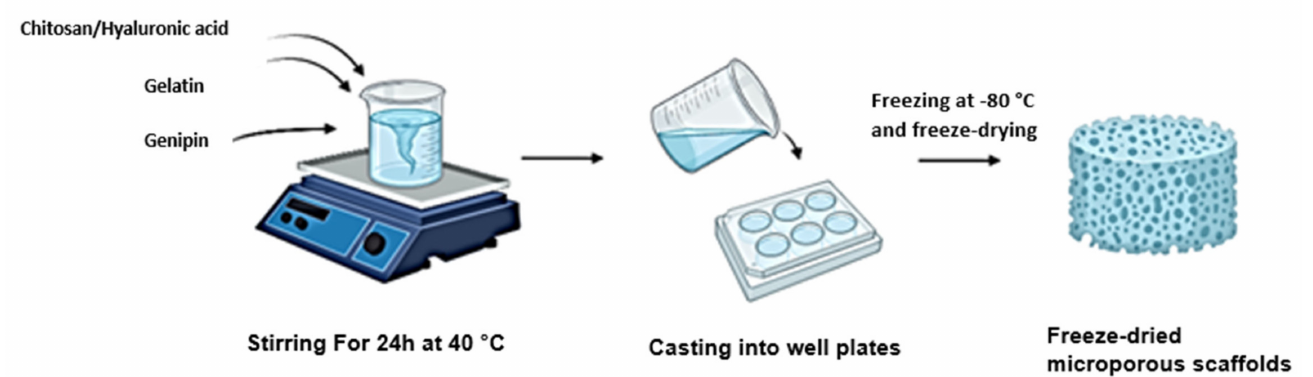
Figure 1. Schematic showing the synthesis of each scaffold through a mixing crosslinking